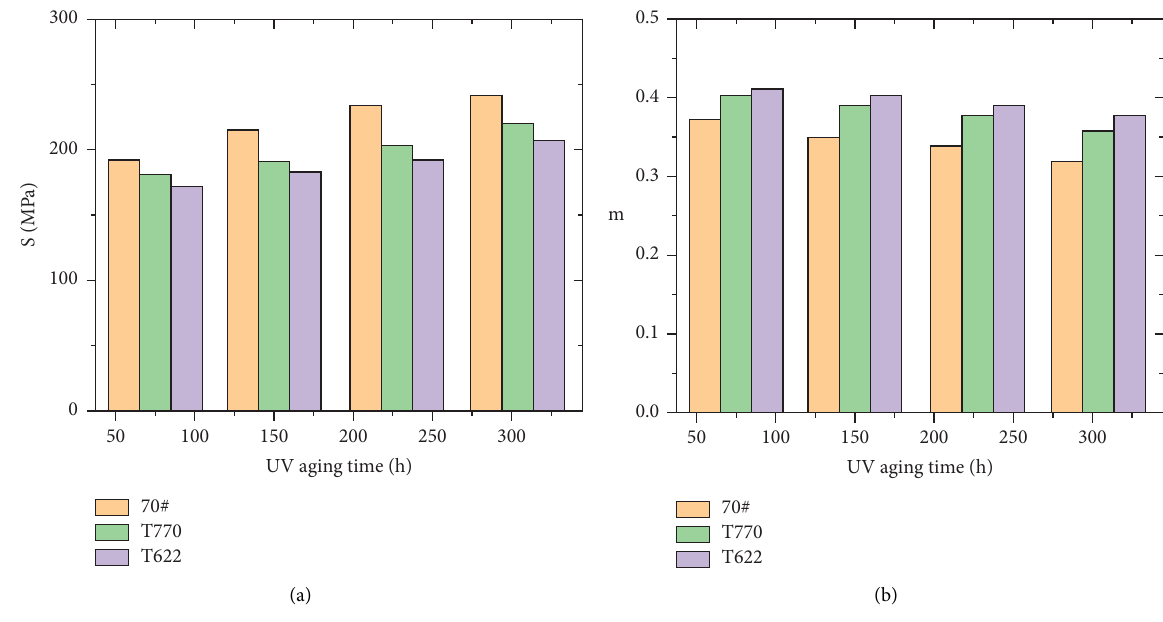
Figure 10: BBR testing results. (a) S . (b) m